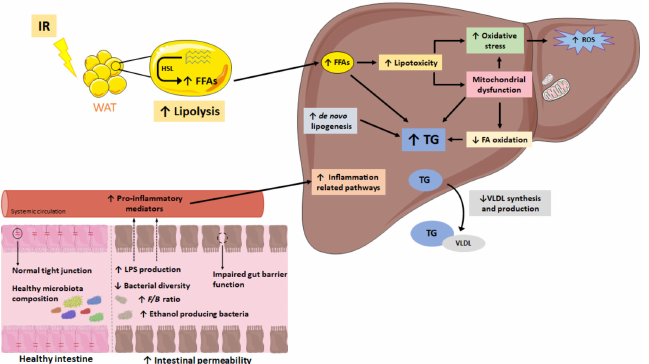
Figure 1. Simplified schematic representation of the events considered in the multiple-hit theory leading to NAFLD development. F / B : Firmicutes / Bacteroidetes ratio; FA: fatty acid; FFA: free fatty acid; HSL: hormone-sensitive lipase; IR: insulin resistance; ROS: reactive oxygen species; TG: triglyceride; VLDL: very-low-density lipoprotein; WAT: white adipose tissue. ↑ : increase; ↓ :